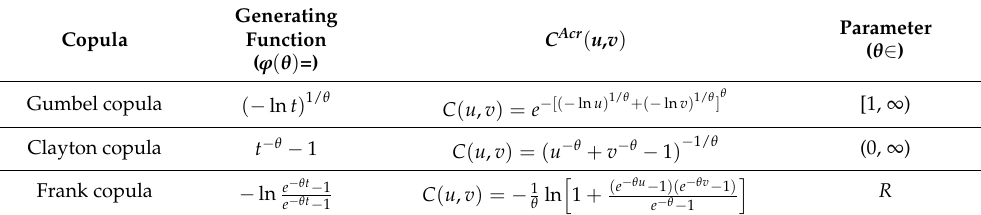
Table 1. Archimedean copula